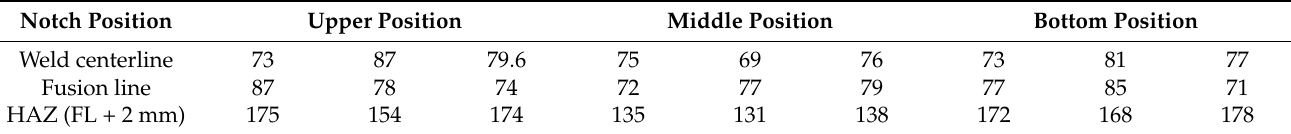
Table 8. Impact toughness of the welded joints at − 40 ◦